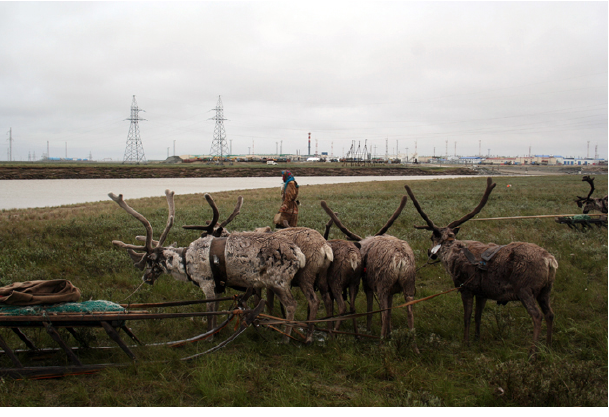
Fig. 7 . Reindeer resting among infrastructure during migration through BGF, July 2011. Photo by B.C.